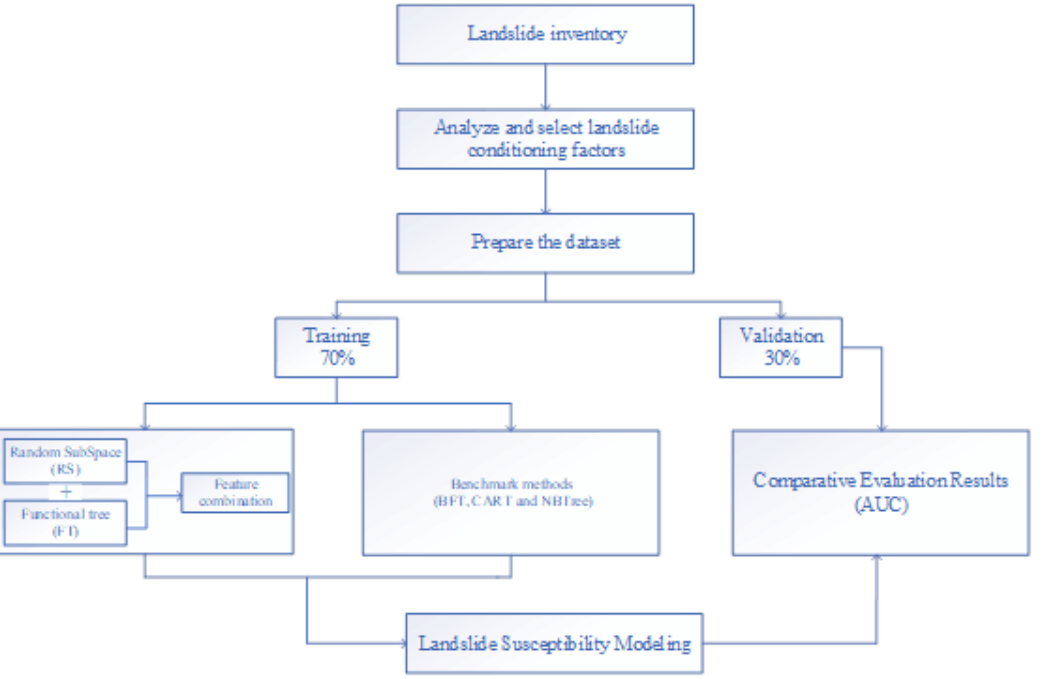
Figure 3. Flowchart of the study.